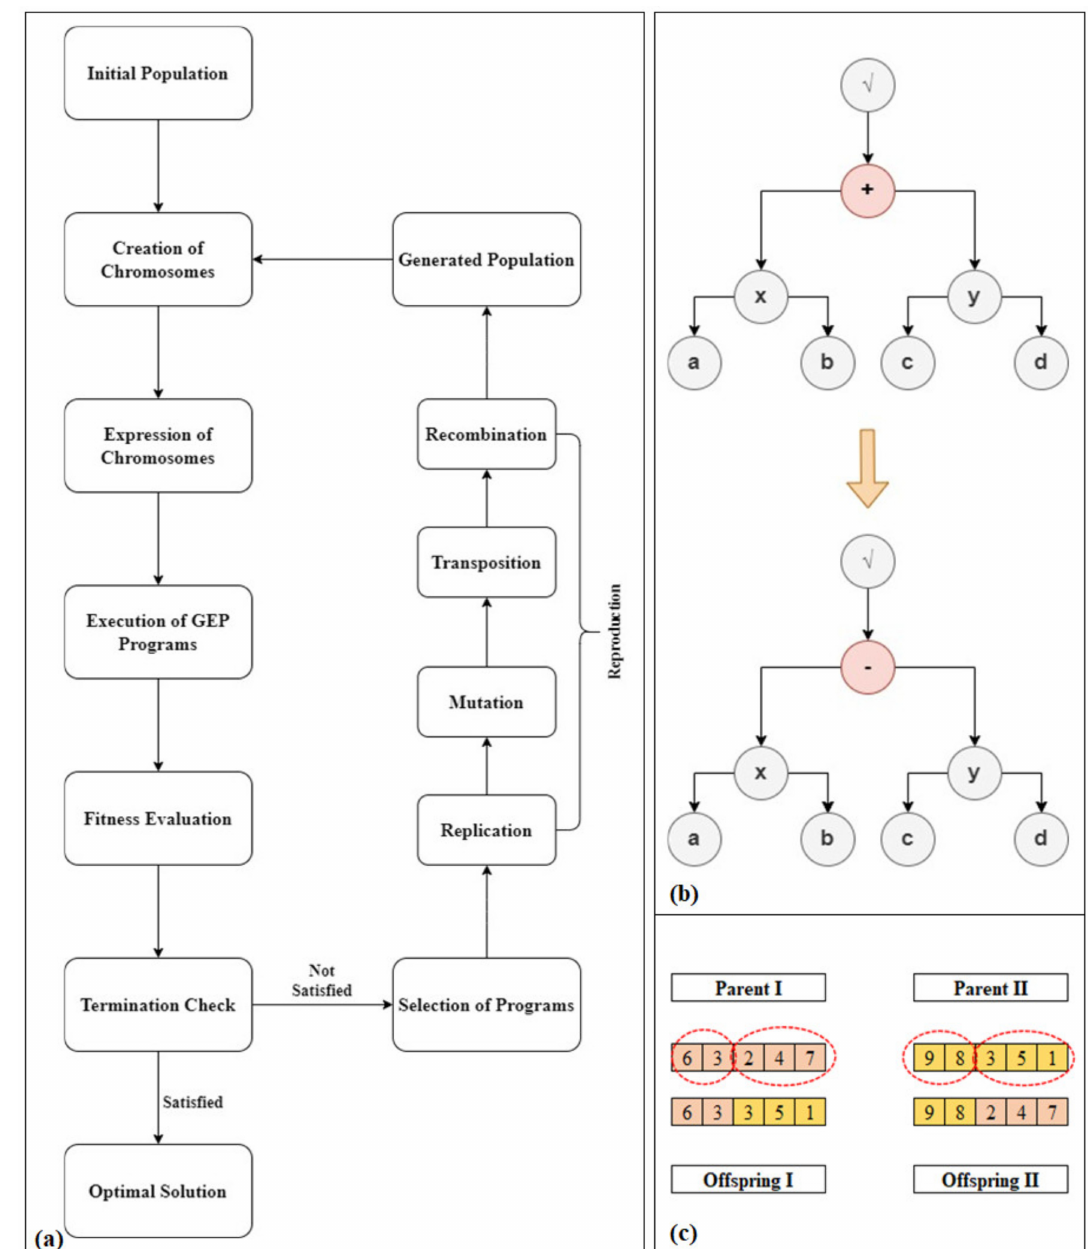
Figure 2. ( a ) GEP Algorithm ( b ) Mutation Process ( c ) Crossover